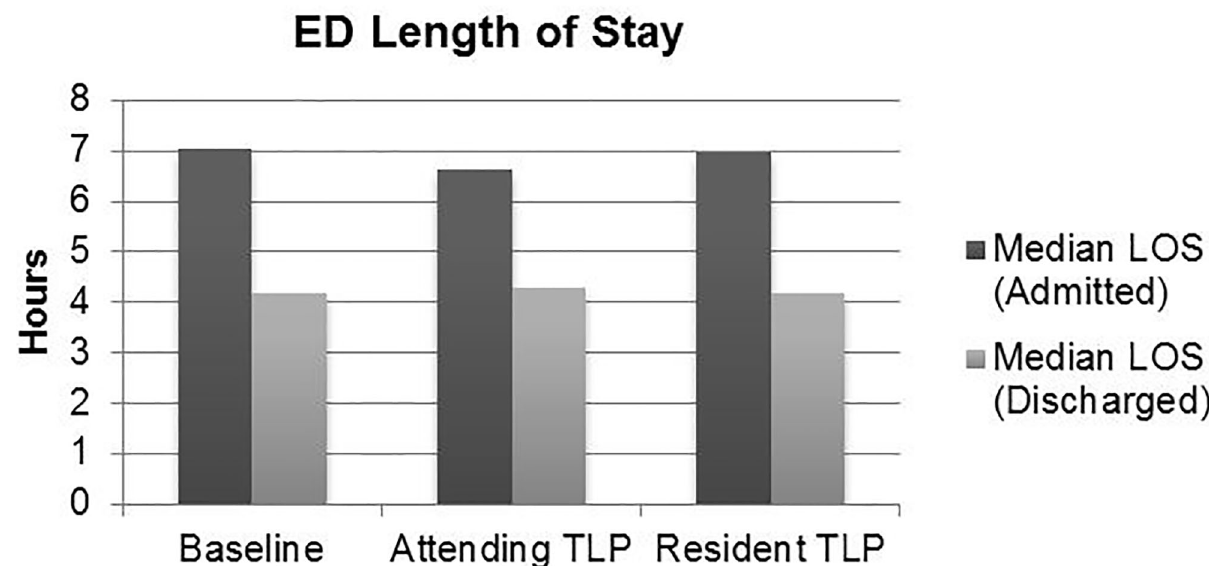
Figure 3. Difference in ED length of stay between attending TLP, resident TLP, and historical control.